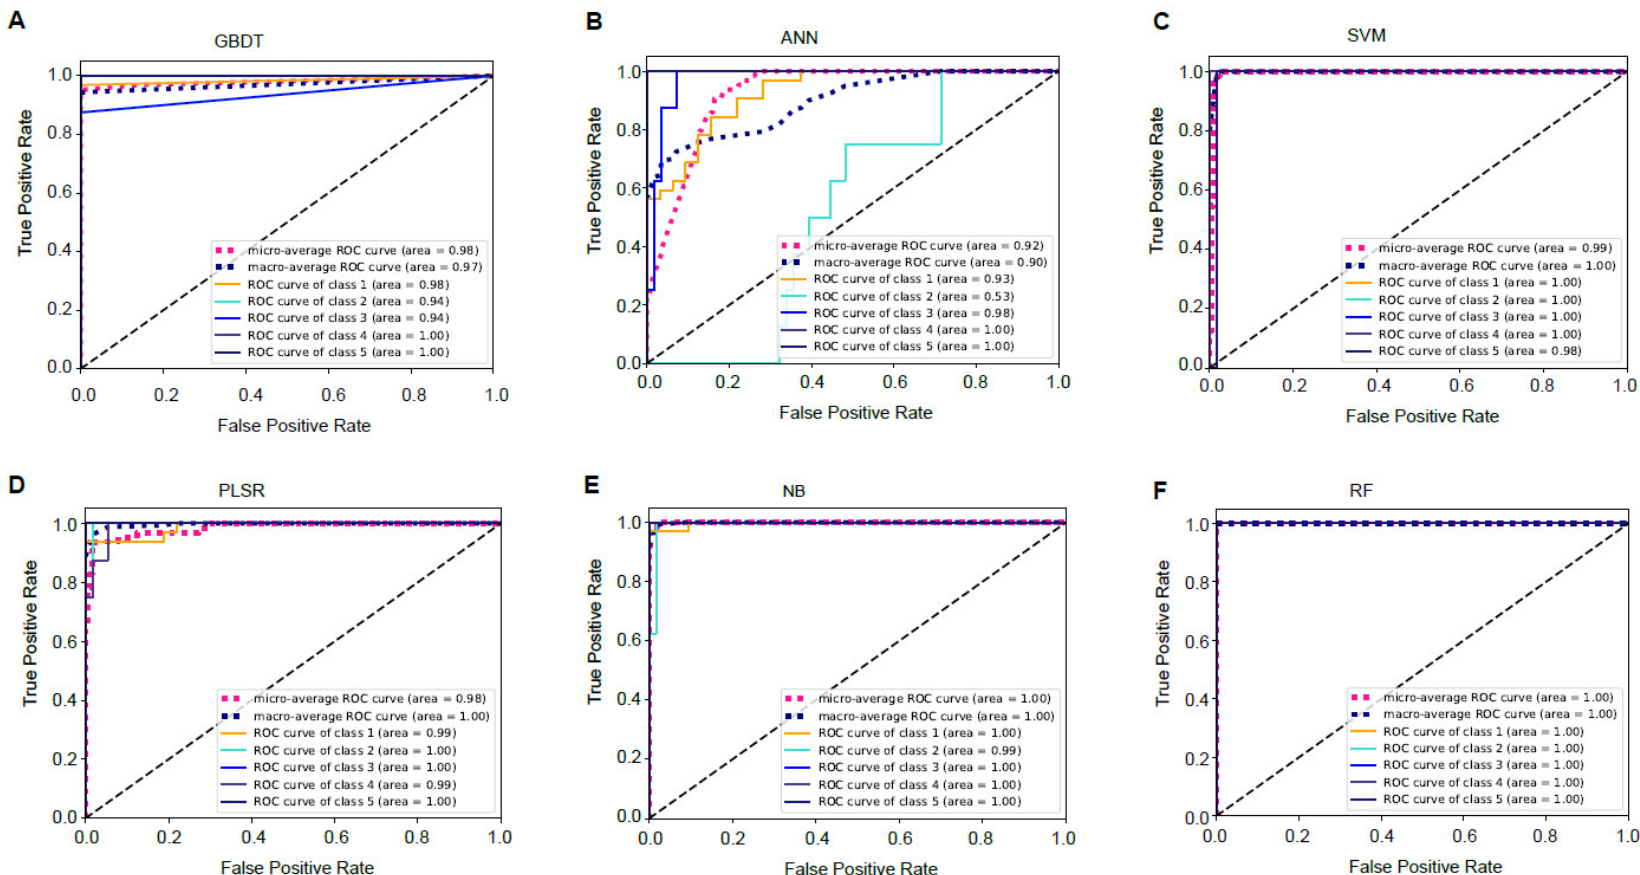
Figure 4. Receiver operating characteristic (ROC) curves for the six machine learning models. ( A ) Gradient boosting decision tree model. ( B ) Artificial neural network model. ( C ) Support vector machine model. ( D ) Partial least squares regression model. ( E ) Naïve Bayes model. ( F ) Random forest model.